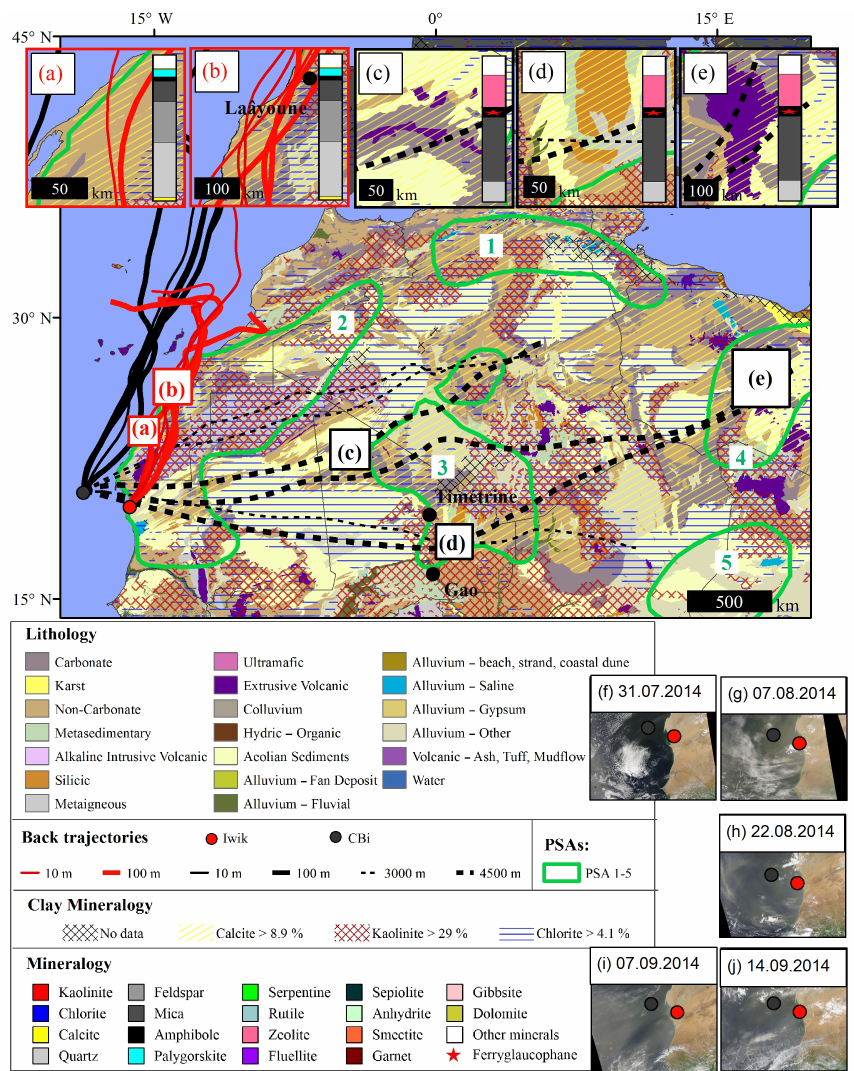
Figure 12. High- (4500m) and low-level (10m) 4-day back trajectories of dust events ending during the sampling interval 15 August– 15 September 2014 at site Iwik and during the sampling interval 1–21 August 2014 at site CBi. The potential source areas and the mineralogy of the samples are given in panels (a–e) . The dust storm events are indicated in panels (f–j)